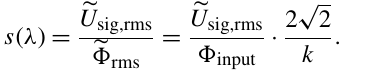
of (cid:101) (cid:56) rms from (cid:56) input will be described in the following. The quantities are also illustrated in Fig.